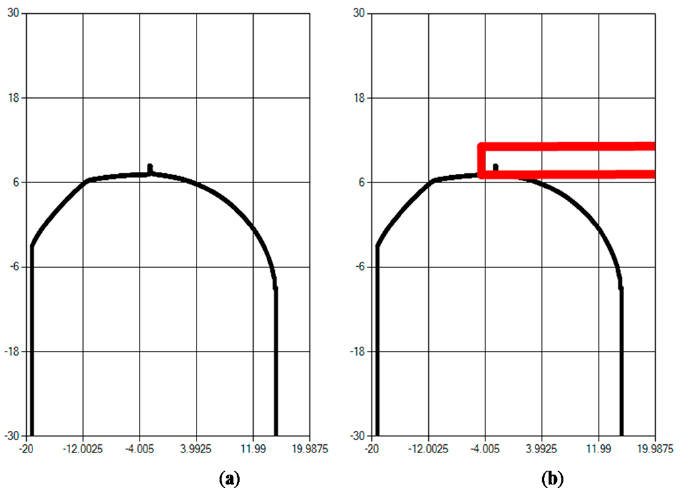
Figure 11. Cross − sectional contour information of bicycle fork (red box is the schematic of deburring tool): ( a ) contour information and ( b ) cutter trajectory.